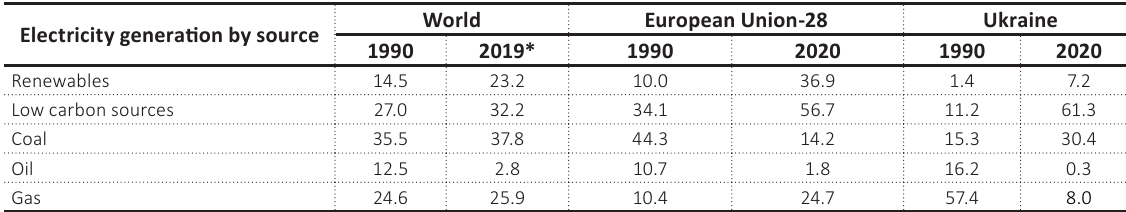
Source: Compiled according to IEA